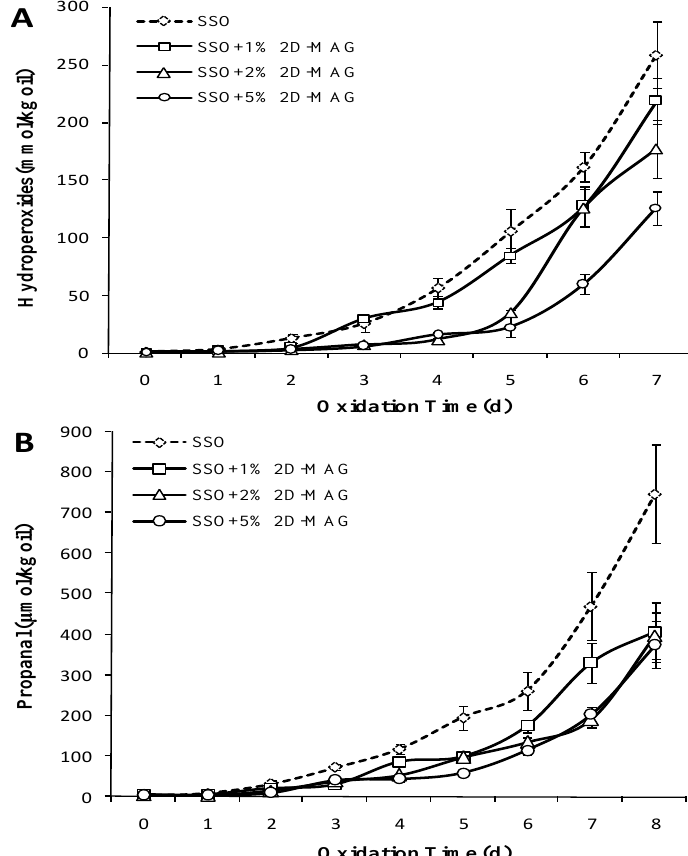
Figure 3. E ff ect of di ff erent concentrations of 2 wt% monoglycerides with DHA (2D-MAG) structured Figure 3. Effect of different concentrations of 2 wt% monoglycerides with DHA (2D-MAG) lipids on the content of refined oil POV ( A ) and propanal ( B ) in SSO (50 ◦ structured lipids on the content of refined oil POV ( A ) and propanal ( B ) in SSO (50 °C).